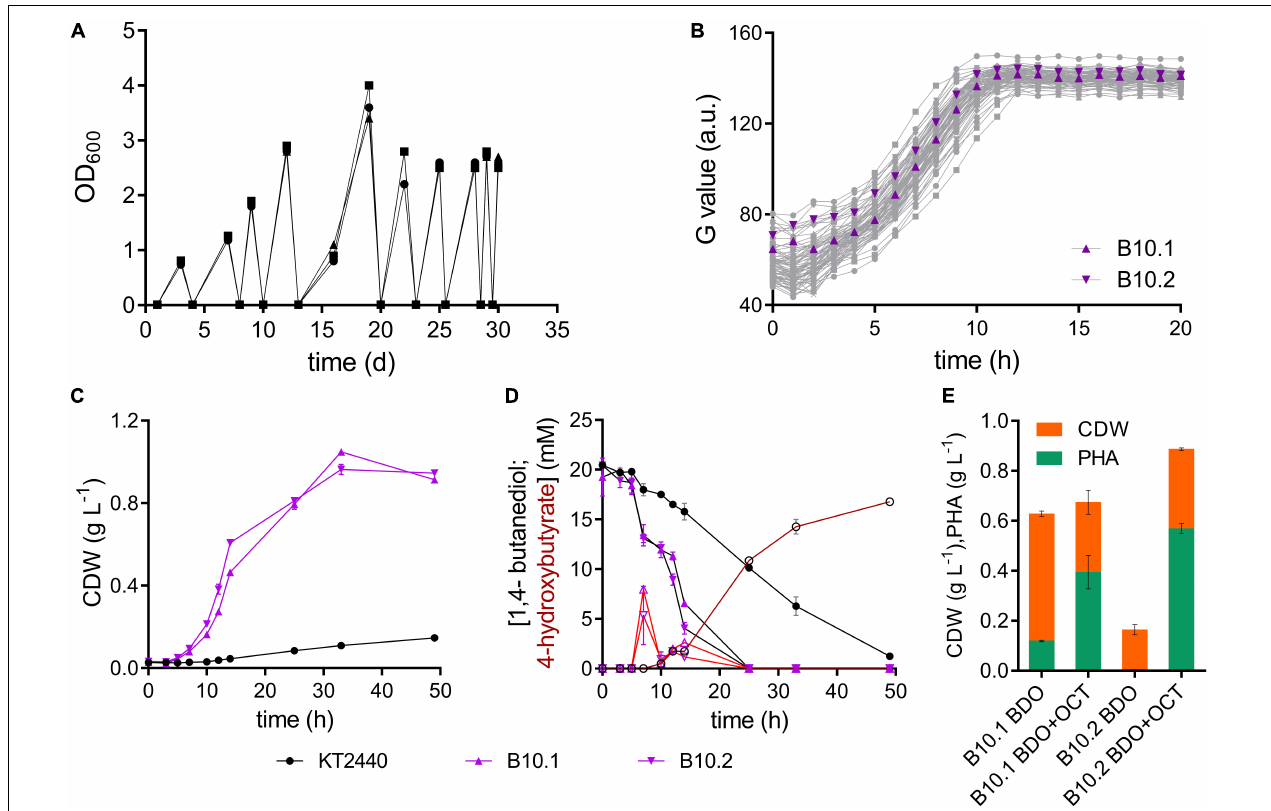
FIGURE 1 | Adaptive laboratory evolution of P. putida KT2440 on 1,4-butanediol. (A) Three parallel sequential batch cultivations on MSM with 20 mM 1,4-butanediol. (B) Growth of single strains isolated from each ALE batch on MSM with 20 mM 1,4-butanediol. The strains B10.1 (purple triangle) and B10.2 (purple inverted triangle) were selected for further investigation. Growth was detected via a Growth Profiler R (cid:13) using a 96-well plate. (C) Biomass growth and (D) 1,4-butanediol (closed symbols, black lines) and 4-hydroxybutyrate (open symbols, red lines) measured in cultures of the wildtype and evolved strains B10.1 and B10.2 in MSM with 20 mM 1,4-butanediol. (E) Growth and PHA formation of strains B10.1 and B10.2 cultivated for 48 h in nitrogen-limited MSM medium with 80 mM 1,4-butanediol (BDO), supplemented with or without 20 mM octanoic acid (OCT) after 24 h. Cultures took place in 250 mL Erlenmeyer shake flasks with a culture volume of 50 mL. Error bars indicate the deviation of the mean ( n =